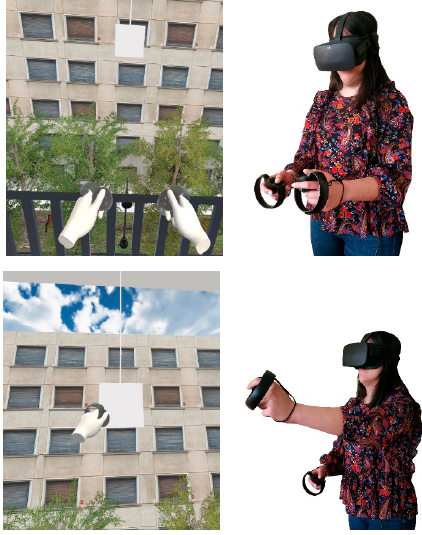
Figure 9. Demonstration of the VR-HC simulation during the procedure.